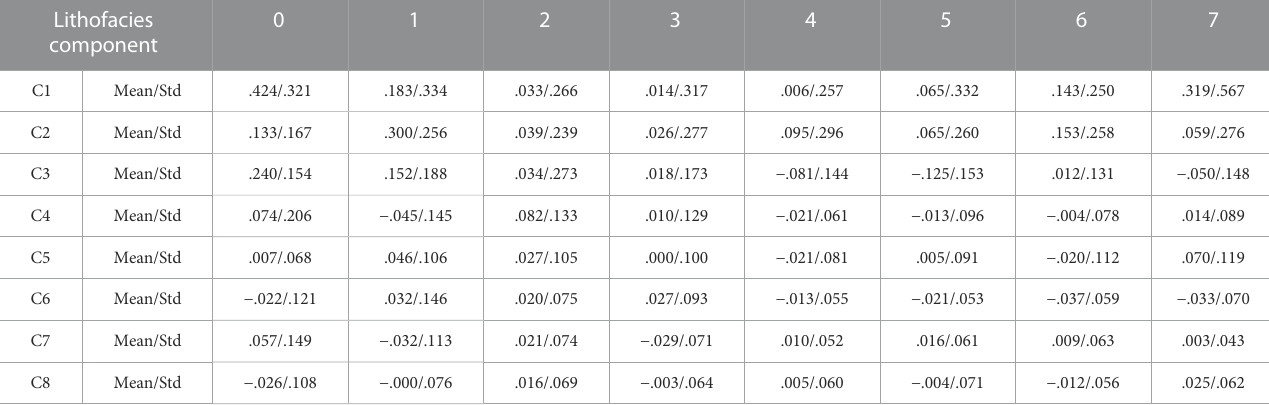
TABLE 3 Statistical table of the characteristic Gaussian parameter (Mean and Std) values for the input data corresponding to different lithofacies in the second section of the Sangonghe Formation in the Moxizhuang area. Lithofacies component